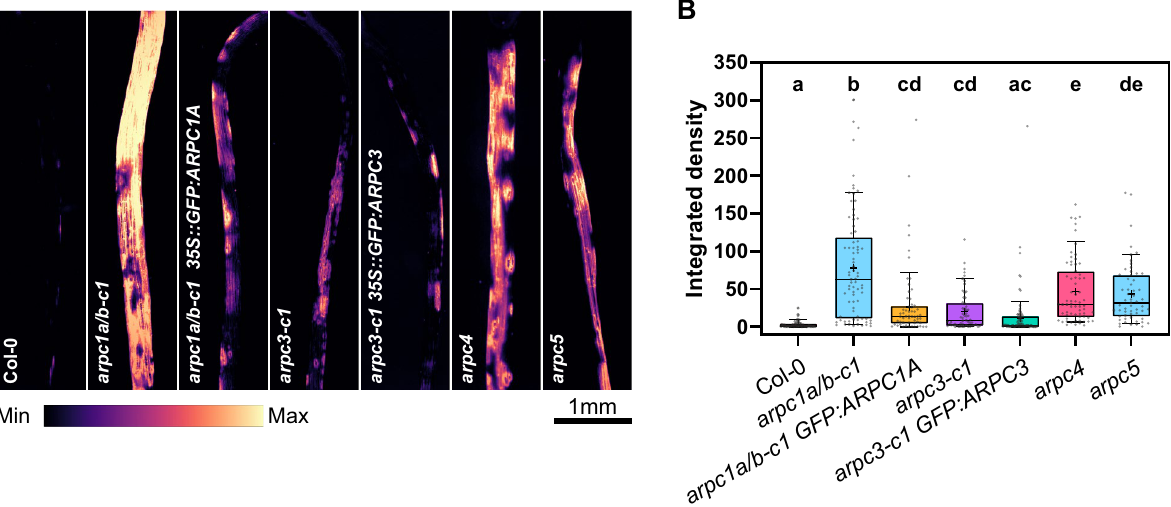
Figure 5. Cell adhesion analysis of etiolated hypocotyls. Increased cell adhesion problems are observed in plants with altered ARP2/3 complex subunit stoichiometry, as revealed by the staining of de-esterified pectins by Ruthenium red in 6-day-old etiolated seedlings. ( A ) Representative micrographs (mpl-magma LUT) of dark-grown plants stained for 15 min in a 0.1% Ruthenium red solution. ( B ) Quantification of the extent of dye penetration as integrated density in the labeled hypocotyls. Statistical analysis was performed fitting a linear mixed model on the original data followed by posthoc Tukey contrasts. Different letters denote statistical significance ( p < 0.01). n = 53–67